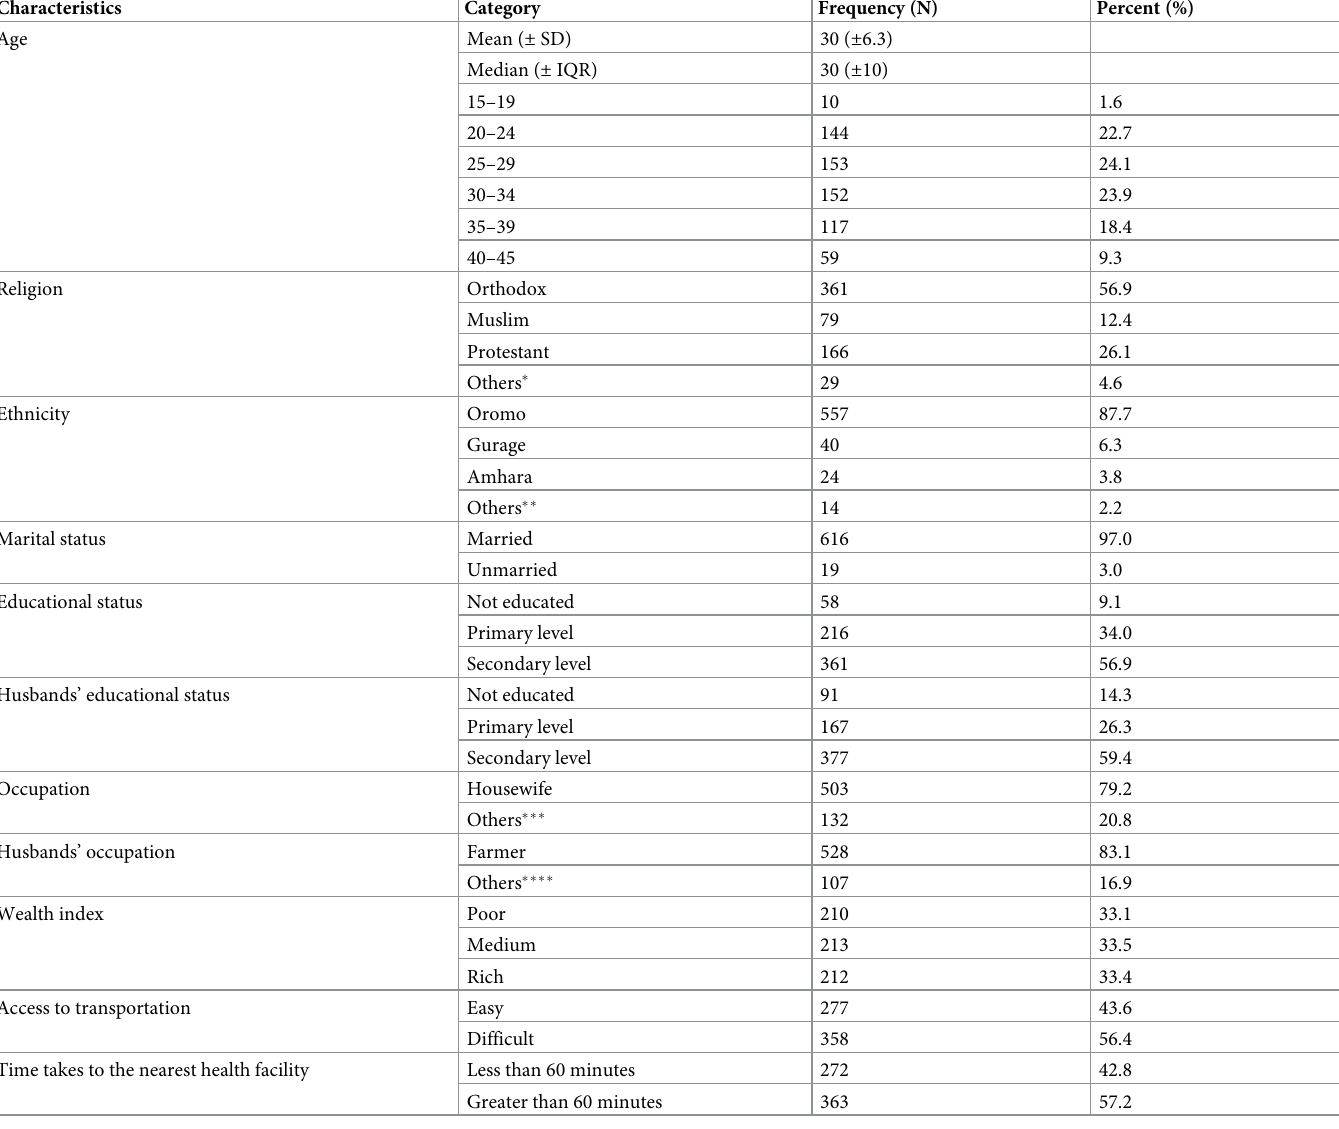
Table 1. Sociodemographic characteristics of childbearing women in Finfinnee special zone of central Ethiopia (N = 635).